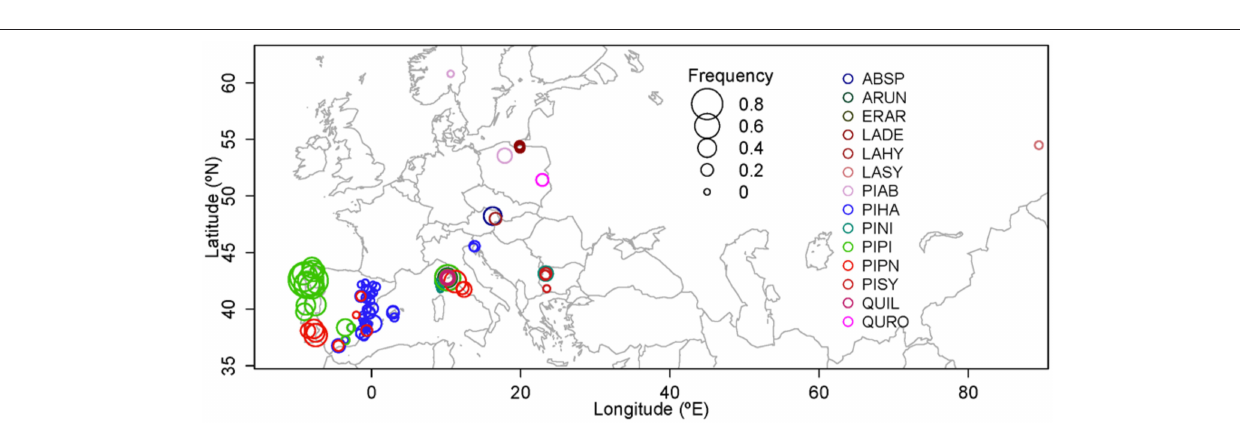
FIGURE 2 | IADF frequency as observed in the 108 populations included in the catalog created during COST FP1106 “STReESS.” ABSP, Abies species; ARUN, Arbutus unedo L.; ERAR, Erica arborea L.; LADE, Larix decidua Mill.; LAHY, Larix decidua x kaempferi ; LASY, Larix sibirica Ledeb; PIAB, Picea abies (L.) Karst; PIHA, Pinus halepensis Mill.; PINI, Pinus nigra Arn.; PIPI, Pinus pinaster Aiton; PIPN, Pinus pinea L.; PISY, Pinus sylvestris L.; QUIL, Quercus ilex L.; QURO, Quercus robur